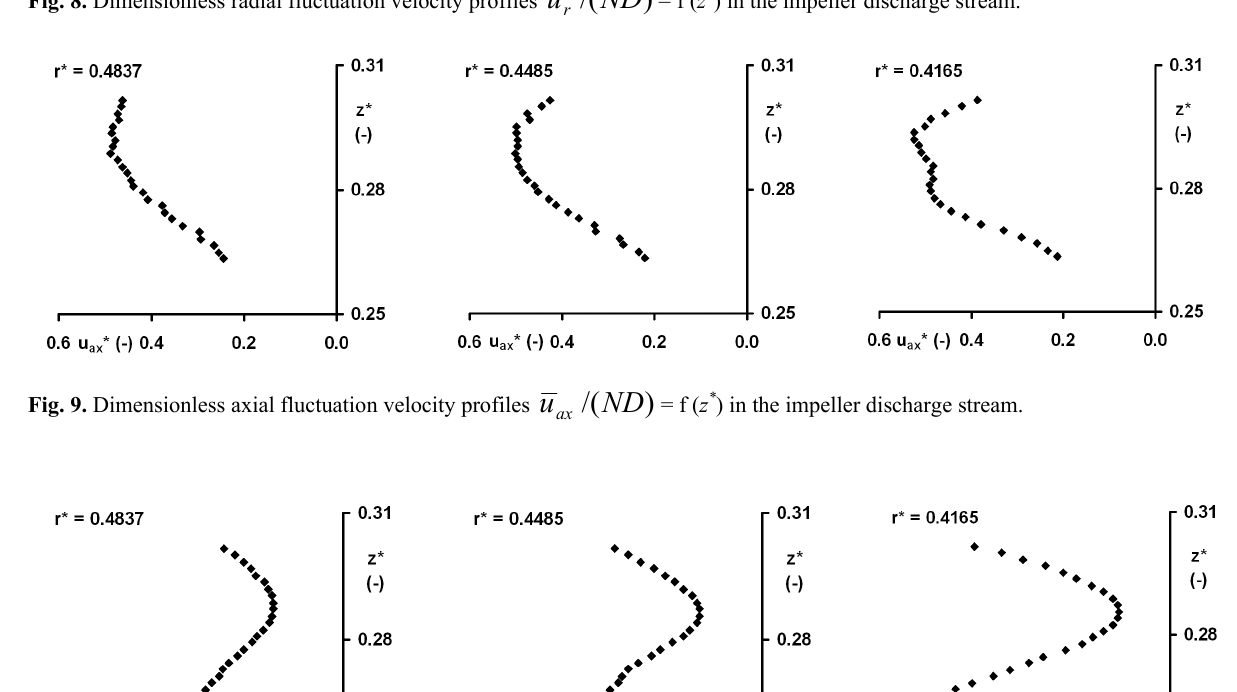
Fig. 8. Dimensionless radial fluctuation velocity profiles )/( NDu